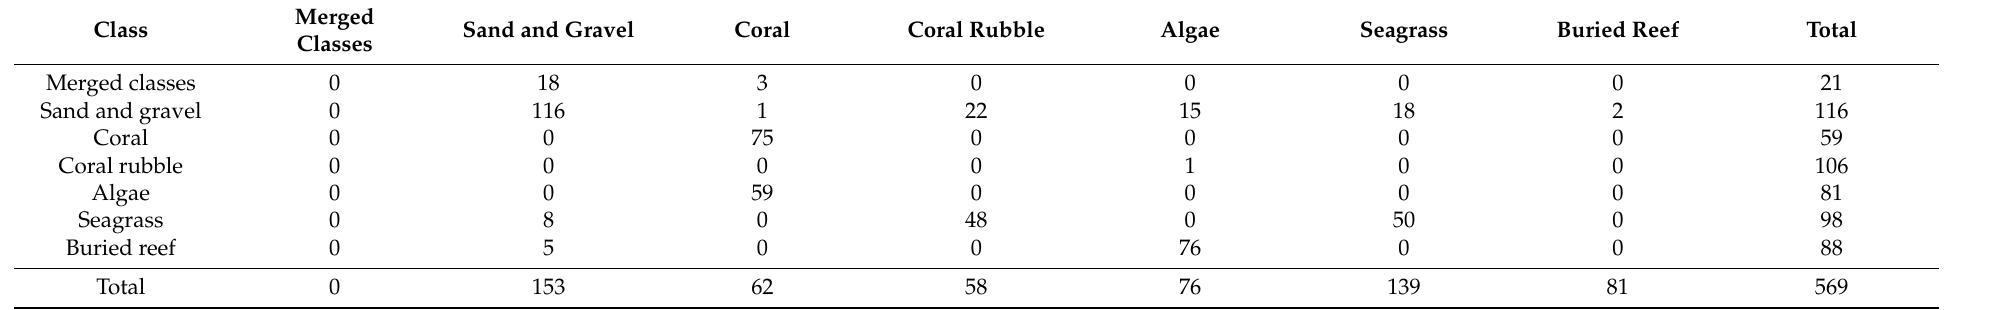
Table 2. The confusion error matrix for the six benthic cover class